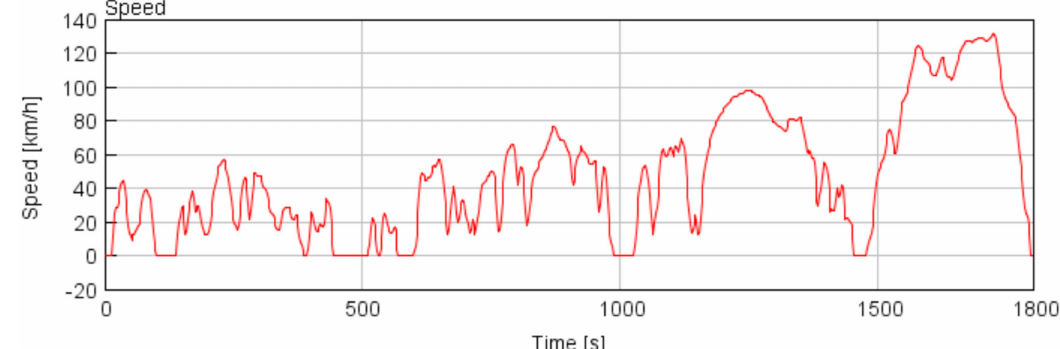
Figure 29. Worldwide Harmonized Light Vehicle Test Cycles (WLTC) Driving